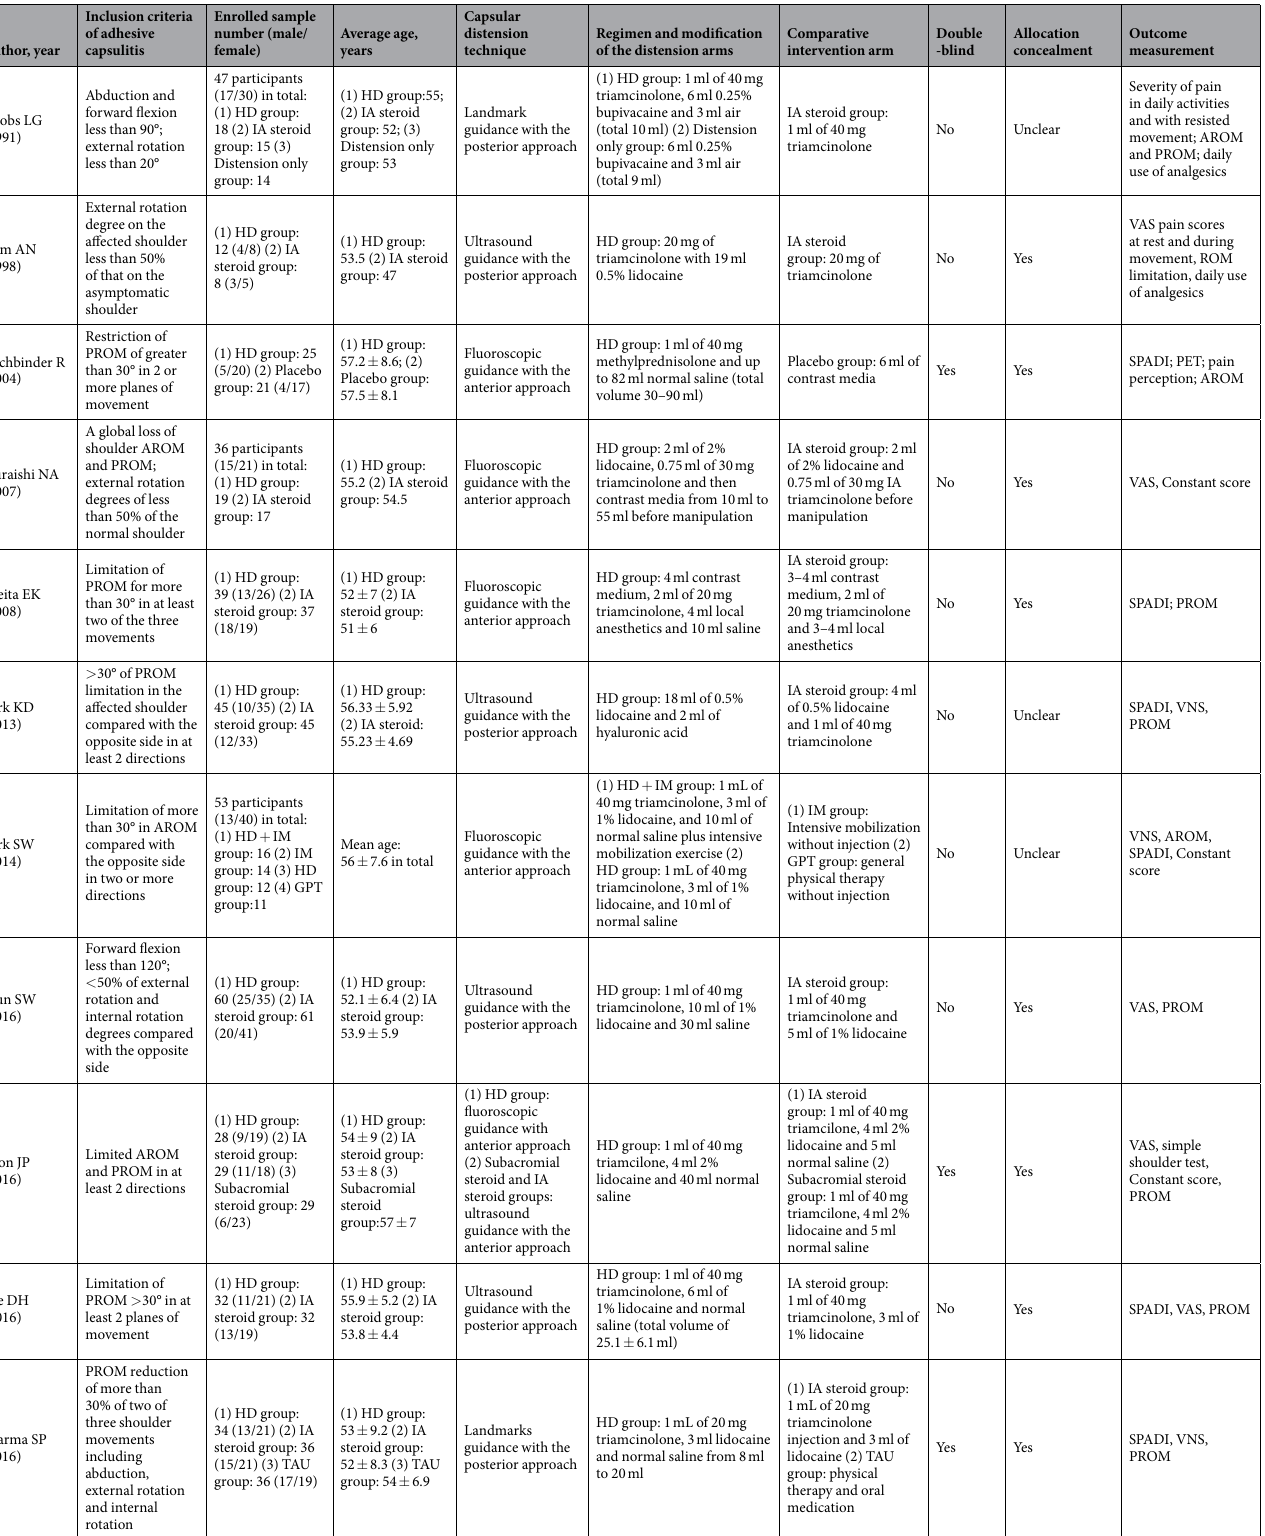
Table 1. Summary of the retrieved trials investigating glenohumeral joint distension on patients with frozen shoulder. Note: AAROM: active assisted ROM; AROM: active ranges of motion; GPT: general physical therapy; HD: hydrodilatation; IA: intra-articular; IM: Intensive mobilization; PROM: passive ranges of motion; ROM: range of motion; SPADI: Shoulder Pain and Disability Index; TAU: treat as usual; VAS: visual analog scale; VNS: Verbal Numeric